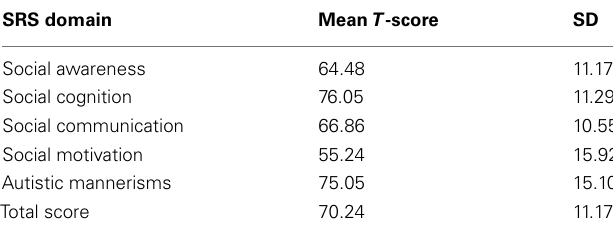
Table 2 | Parent-reported social reciprocity skills.